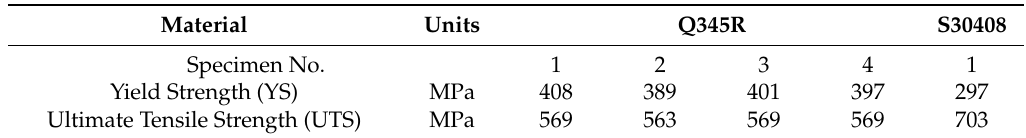
Figure 9. The cross sections of the specimens (S30408, 188, 198 and 200 MPa). Table 1. The conventional tensile test results of Q345R and S30408.